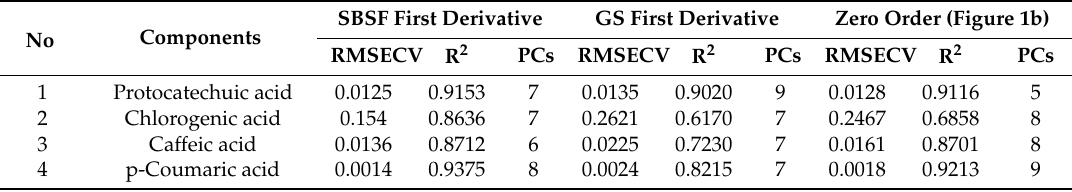
Table 3. RMSECV, R 2 values and, number of PCs determined during the construction of the calibration models.